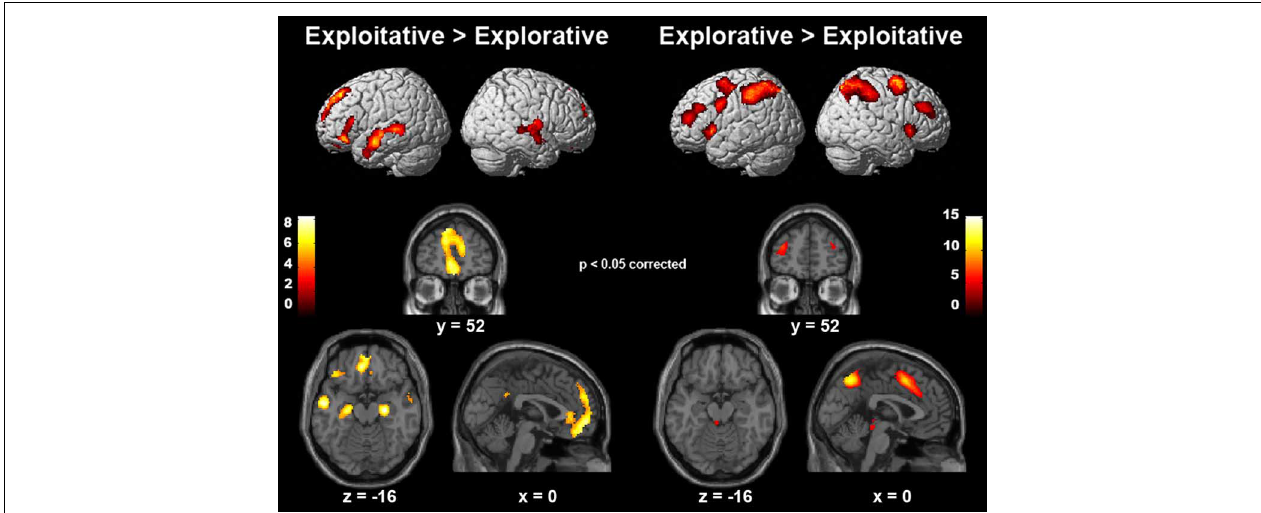
FIGURE 3 | Cerebral regions differentially activated by explorative and exploitative choices. The cerebral regions that were more strongly activated by exploitative than explorative choices (left), and by explorative than exploitative choices (right).